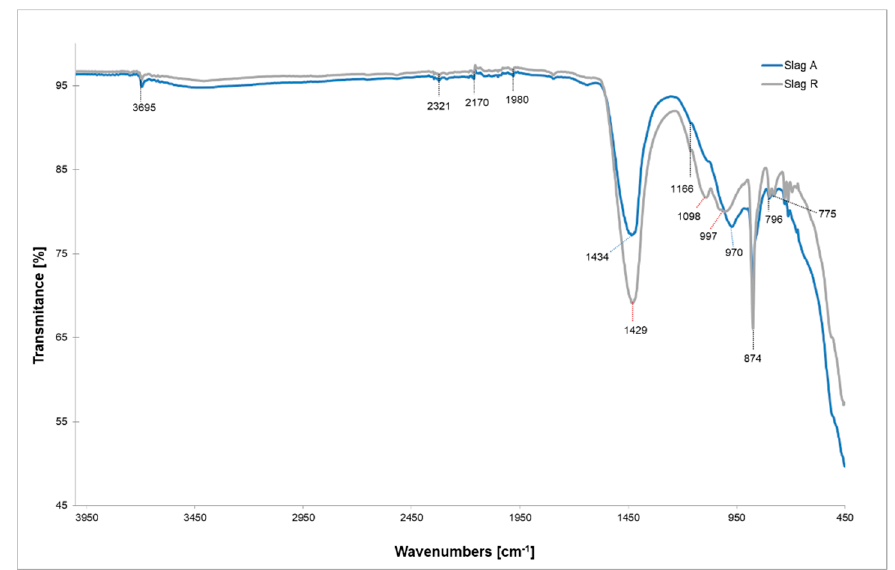
Figure 5. FTIR spectra of precursor materials (Slag A and Slag R).